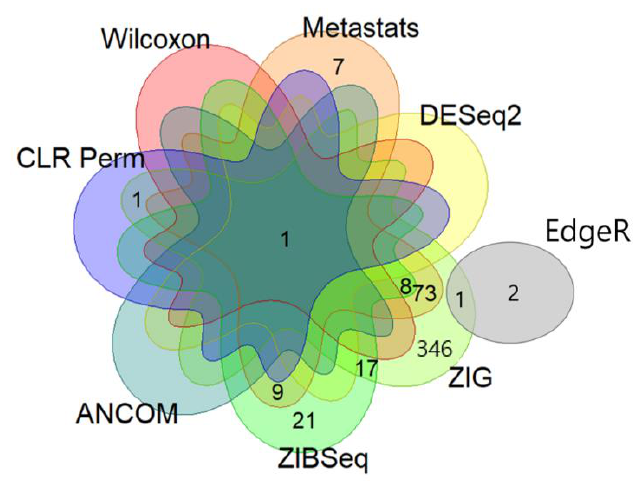
Figure 2. Selection of genus-level microbiome biomarkers. Venn diagram depicts the overlapping of biomarkers among the eight statistical methods.